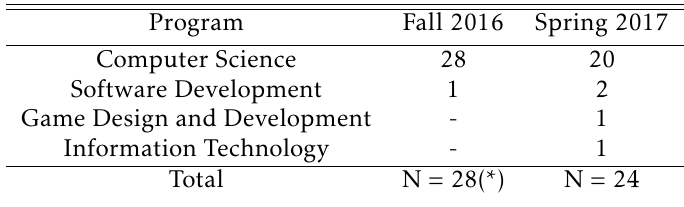
Table 2. Programs of Study by Cohort Size (N). (*) One student in Fall 2016 cohort is studying two programs: Computer Science and Software Development.